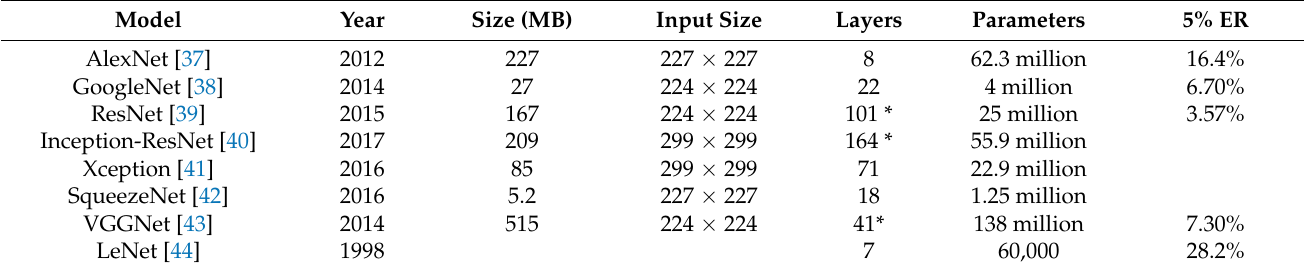
Table 1. General Comparison Summary between Pre-trained CNN